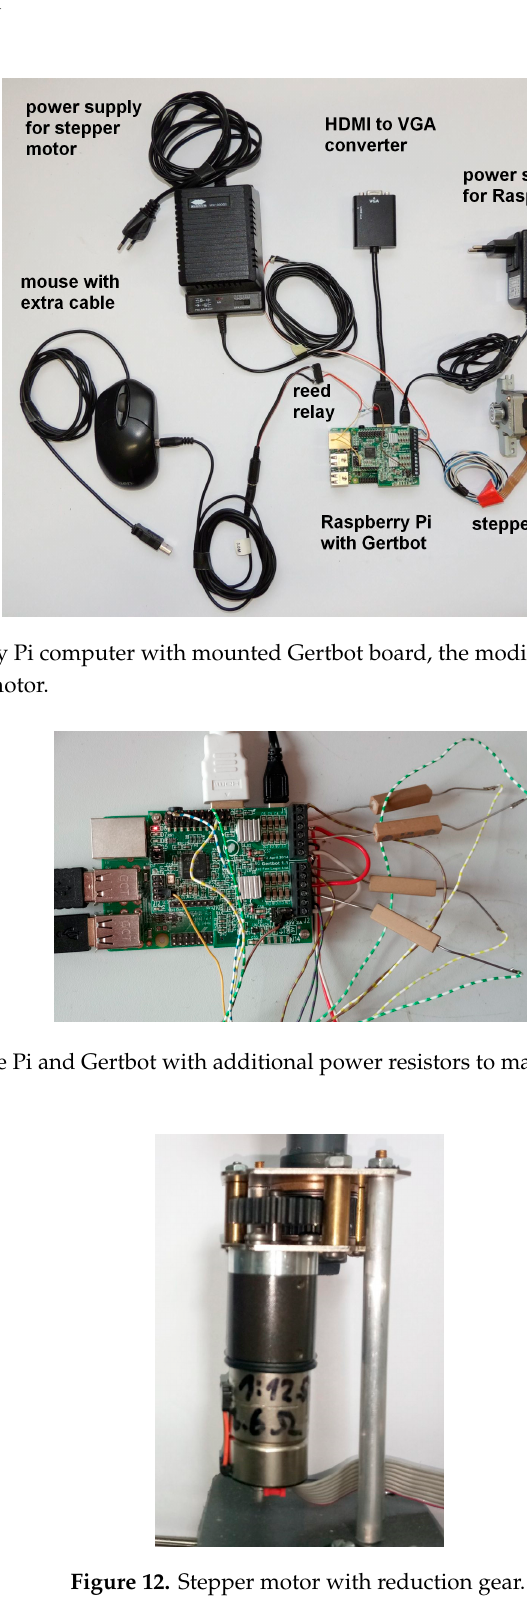
Figure 13. Translation stage with limit switches and mounted motor. 7. The Control Software The control software is available from the author on request. The software requires the turnaround time for the camera including time for exposure, data transmission and storage before it is ready again, the translation ratio of the stepper motors from steps to degrees or mm, and the number of projections over 180 or 360 degrees. The script has a delay of five seconds to give the user time to move the mouse onto the start button of the camera software. A Raspberry Pi 3B is powerful enough to run both the motion control software and the camera software on the same computer, the user only has to move the mouse pointer from the shell window to start button on the camera software. Figure 14 shows a screenshot of the script window and the camera software with multiple camera parameters.